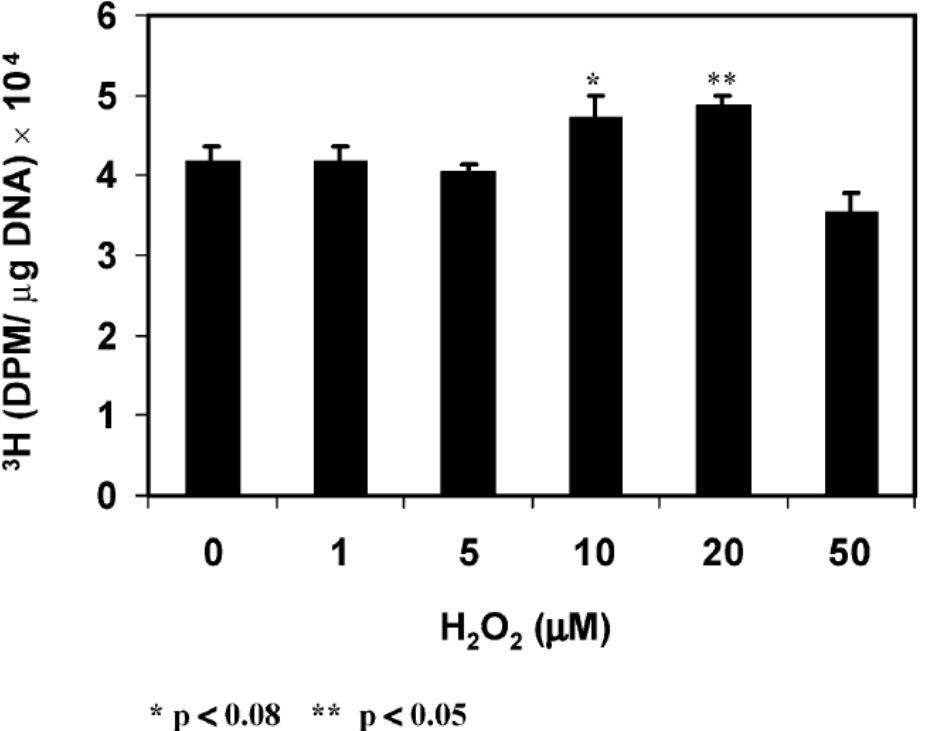
Figure 9. Effect of H 2 O 2 on the proliferation of HLE B3 cells. Cells (5.25 × 10 5 ) were gradually depleted from serum and used for cell proliferation by thymidine incorporation. The cells were exposed to H 2 O 2 (0, 1, 5, 10, 20, 50 µ M) in the presence of (methyl- 3 H)-thymidine (1 µ Ci /mL) for 1 h before harvesting for analysis. Thymidine incorporation in cells is expressed as dpm/ µ g DNA. The data are an average of three separate experiments (mean ± SD) with * p < 0.08 and ** p < 0.05. Reprinted with permission from Chen et al., EER (2004); Copyright Elsevier 2004